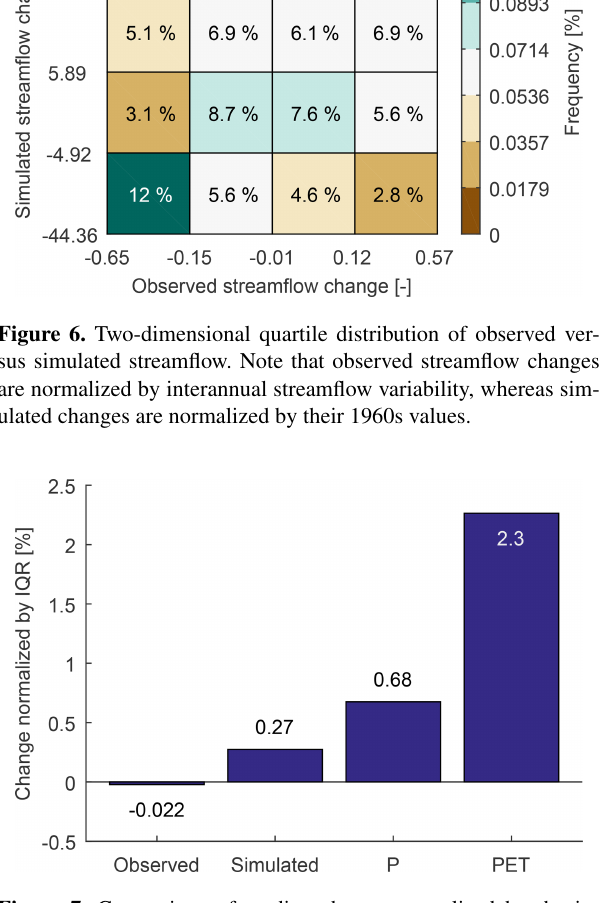
Figure 7. Comparison of median change normalized by the in- terquartile range (IQR) for observed and simulated streamflow and climate forcing. Normalization was done in order to allow for direct comparison of the changes reported by Stahl et al. (2010), who re- ported change normalized by interannual streamflow variability and other fluxes with change expressed in